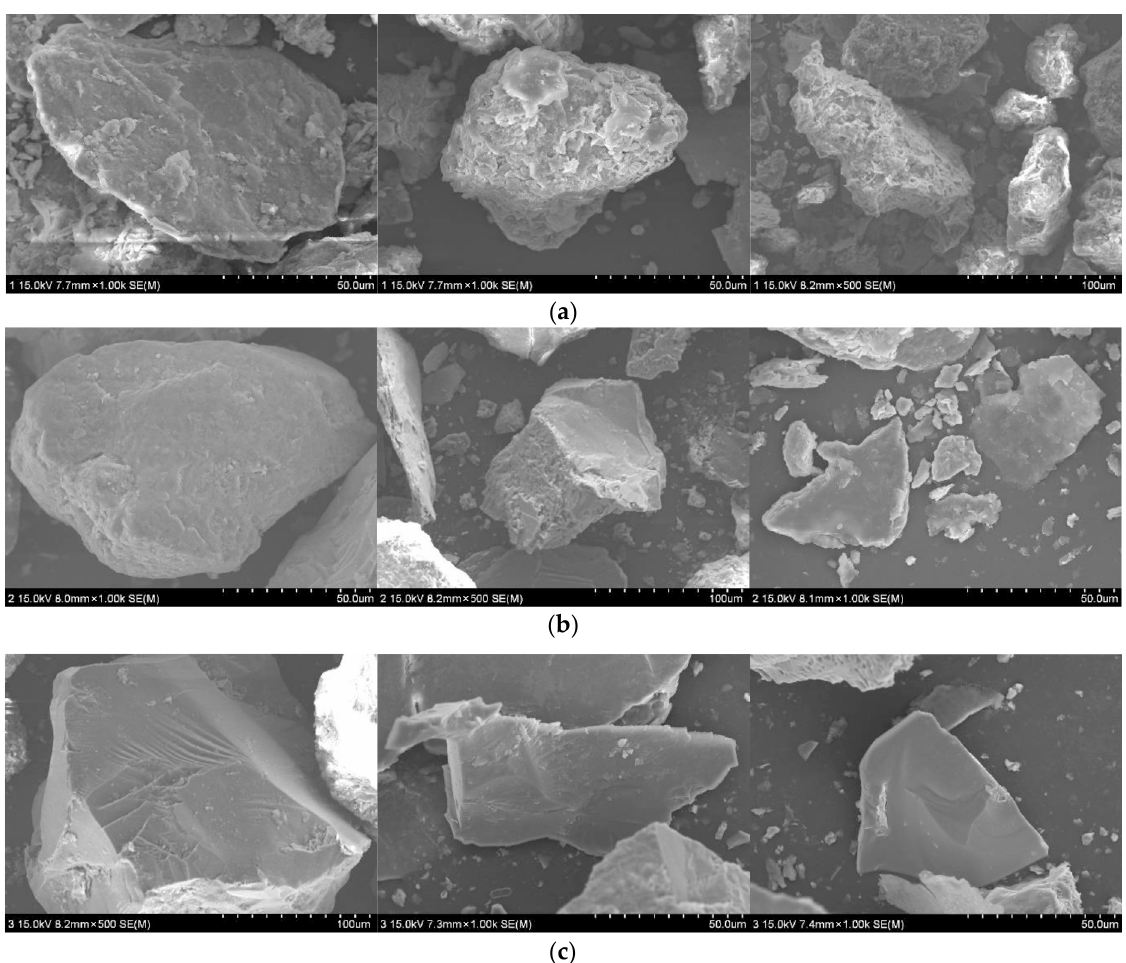
Figure 13. Scanning electron microscopy images of: ( a ) contaminated soil; ( b ) washed soil; and ( c ) soil that has been washed three